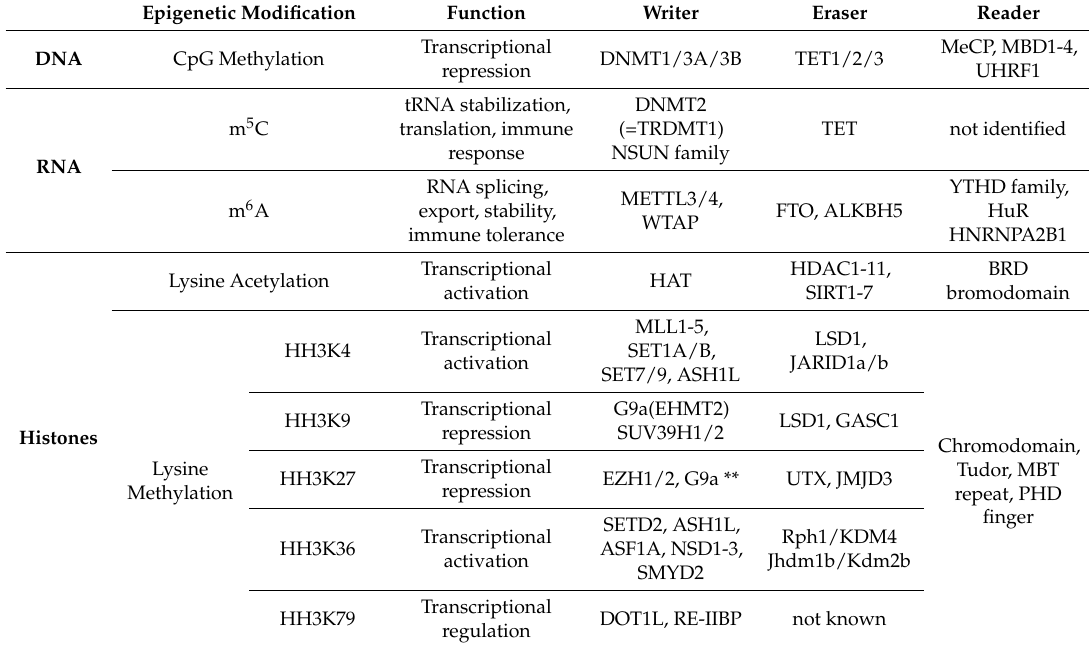
Table 1. Epigenetic modifications. Only DNA and RNA methylation, histone acetylation and some epigenetic modifications for histone H3 are shown with the corresponding players (writers, erasers and readers). For H3K79 methylation, DOT1L functions are multiple: it is involved in telomeric silencing, cellular development, cell-cycle checkpoint, DNA repair, and regulation of transcription. For RNA, only m 5 C and m 6 A are described but other modifications can be found in the review by Esteller